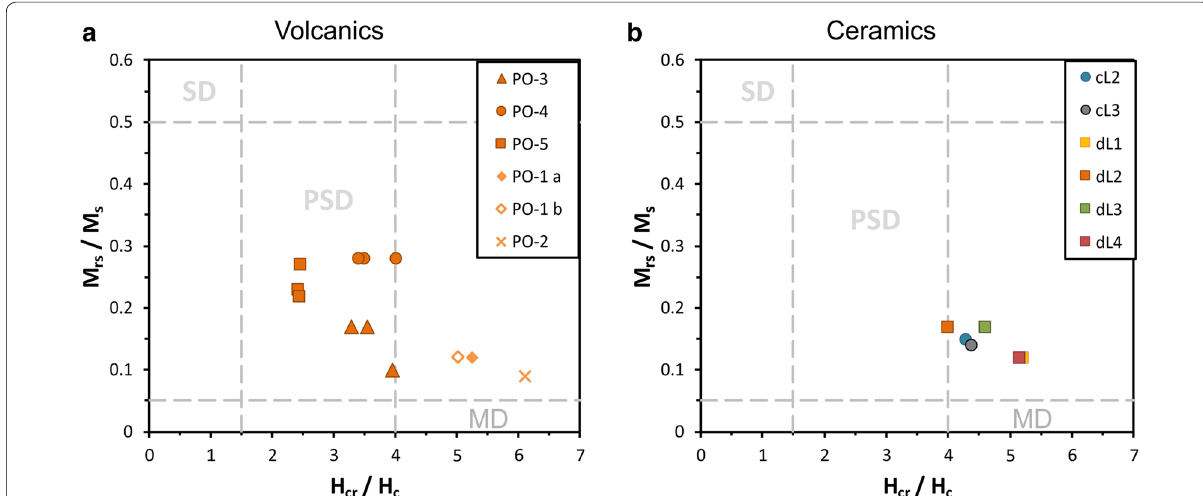
Fig. 10 Corresponding Day plot ( M rs saturation remanence, M s saturation magnetization, B cr remanence of coercivity, B c coercive force) for the lava flows, scoria clast ( a ) and ceramic fragments ( b